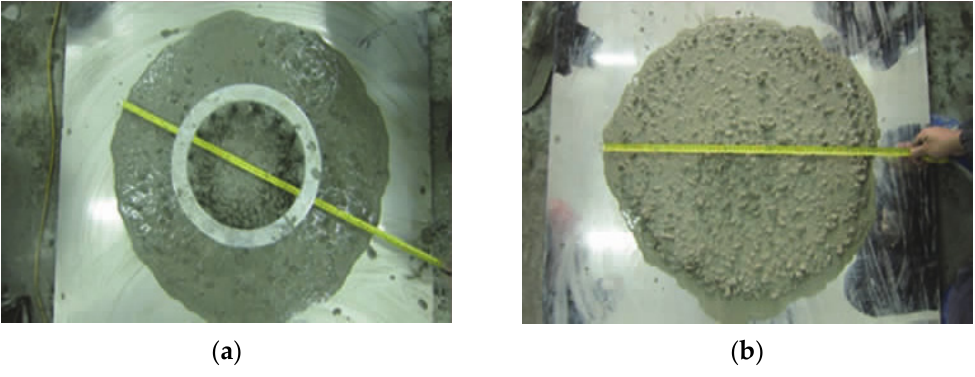
Figure 1. Workability test of RASCC. ( a ) Slump flow; ( b ) J-ring flow. Table 3. Workability and mechanical properties of